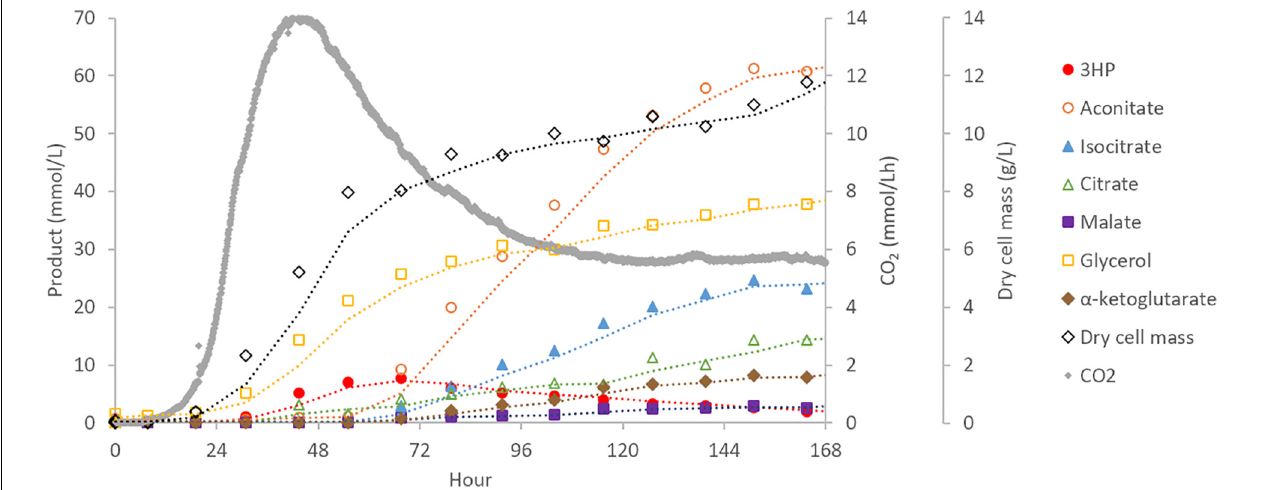
FIGURE 3 | Bioreactor cultivation of A. pseudoterreus for 3HP production. Time-course production of 3HP and other bioproducts detected by extracellular metabolomics.